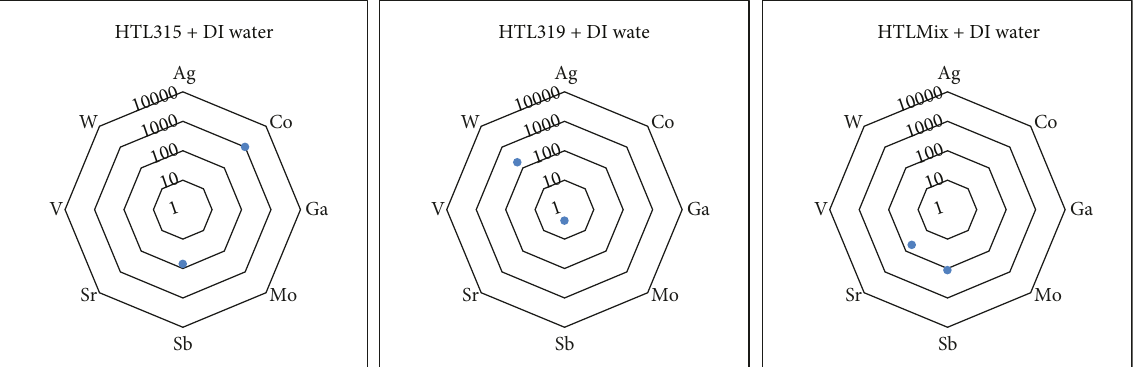
Figure 5: Concentration (in ppb) of the “ at risk ” elements in each sample reacted with deionised water at 70 ° C temperature under 1 bar pressure in batch rotating shakers after 670 hours (absence of data points re fl ects concentrations below the limits of detection).